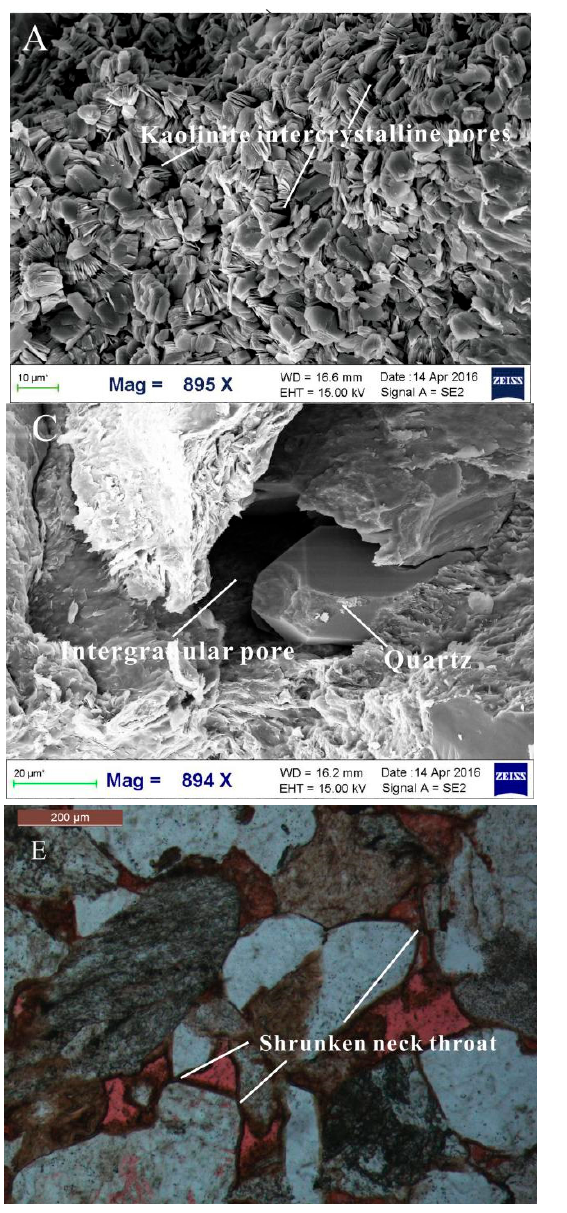
Figure 2. ( A ) Kaolinite intercrystalline pores (Sample No. 10); ( B ) Feldspar dissolved pore, locally developed quartz (Sample No. 8); ( C ) Intergranular pore, locally developed quartz (Sample No. 4); ( D ) Rock fragment dissolution pores (Sample No. 6); ( E ) Shrunken neck throat (Sample No. 1); ( F ) lamellar throat (Sample No. 7). Typical pore and throat types of Chang 8 reservoir. Type II reservoirs have general physical properties. The permeability and porosity on an average across the reservoir are 0.08 × 10 − 3 µ m 2 and 7.63%, respectively. The capillary pressure curve is gentle, with a visible horizontal plateau. The average displacement and median pressures of the reservoir are slightly larger than those of Type I, which are 1.22 and 10.95 MPa, respectively. The average sorting factor is 1.95, and the sorting performance is general. Figure 2C,E reveal that reservoir pores are dominated by residual intergranular holes, feldspar-dissolved pores, a small number of micro pores, and a narrow neck throat. Thus, sample Nos. 1, 4, and 5 belong to this type of reservoir. Nano-CT scanning was then performed on sample No. 1 to observe its pore throat distribution. Figure 3A,B show that the sample contains substantially small pores, a certain amount of large pores distributed